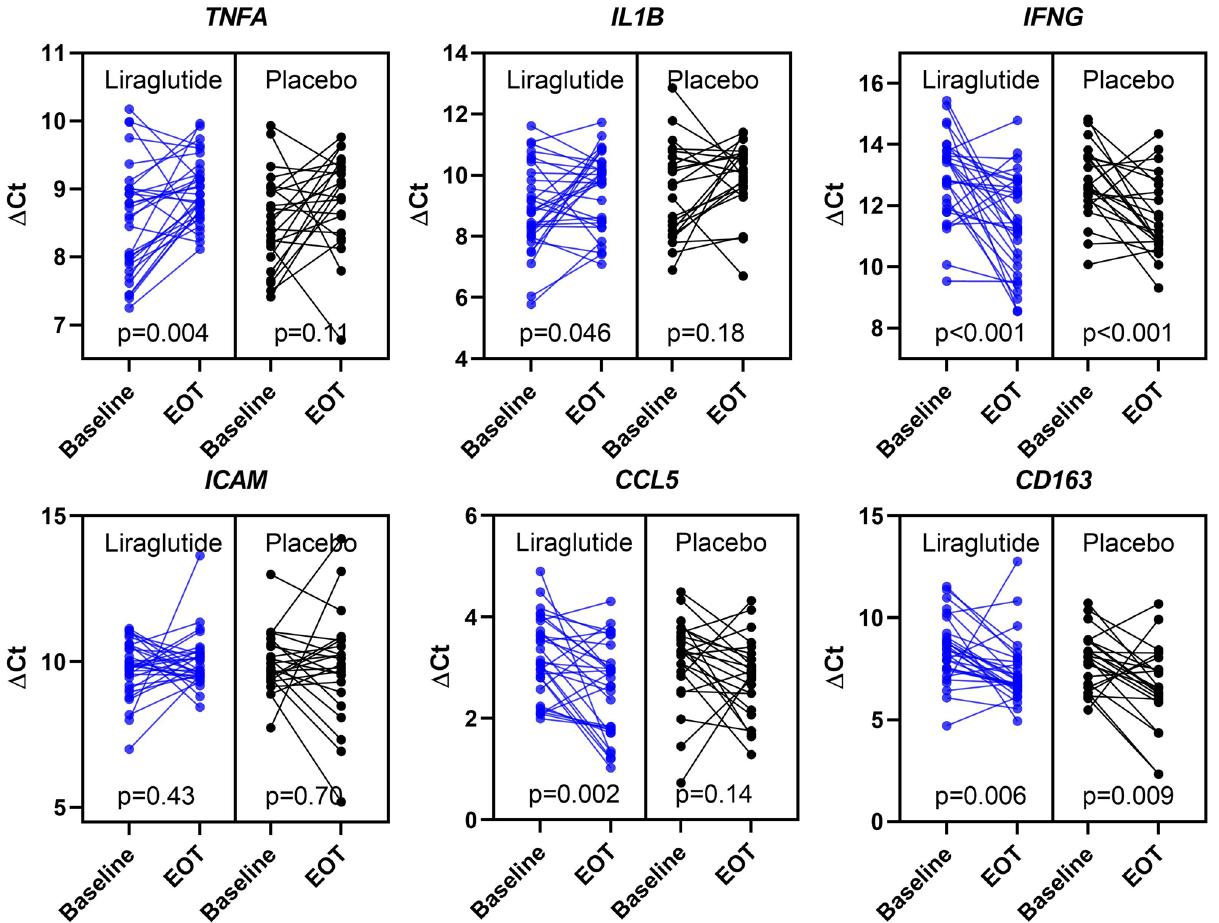
Figure 1. Effects of 26 weeks of treatment with liraglutide or placebo on the expression of inflammatory genes in isolated peripheral blood mononuclear cells in patients with T2D. Gene expression of selected inflammatory genes at baseline and end-of treatment measured by quantitative real-time polymerase chain reaction. Levels are for the individual participants in the liraglutide (n = 31) and the placebo (n = 23) treated group. Ct cycle threshold. ∆Ct = Ct (gene of interest) – Ct ( ACTB ), a decrease in ∆Ct values can be interpreted as an upregulation of the gene. P values from paired t-test. EOT